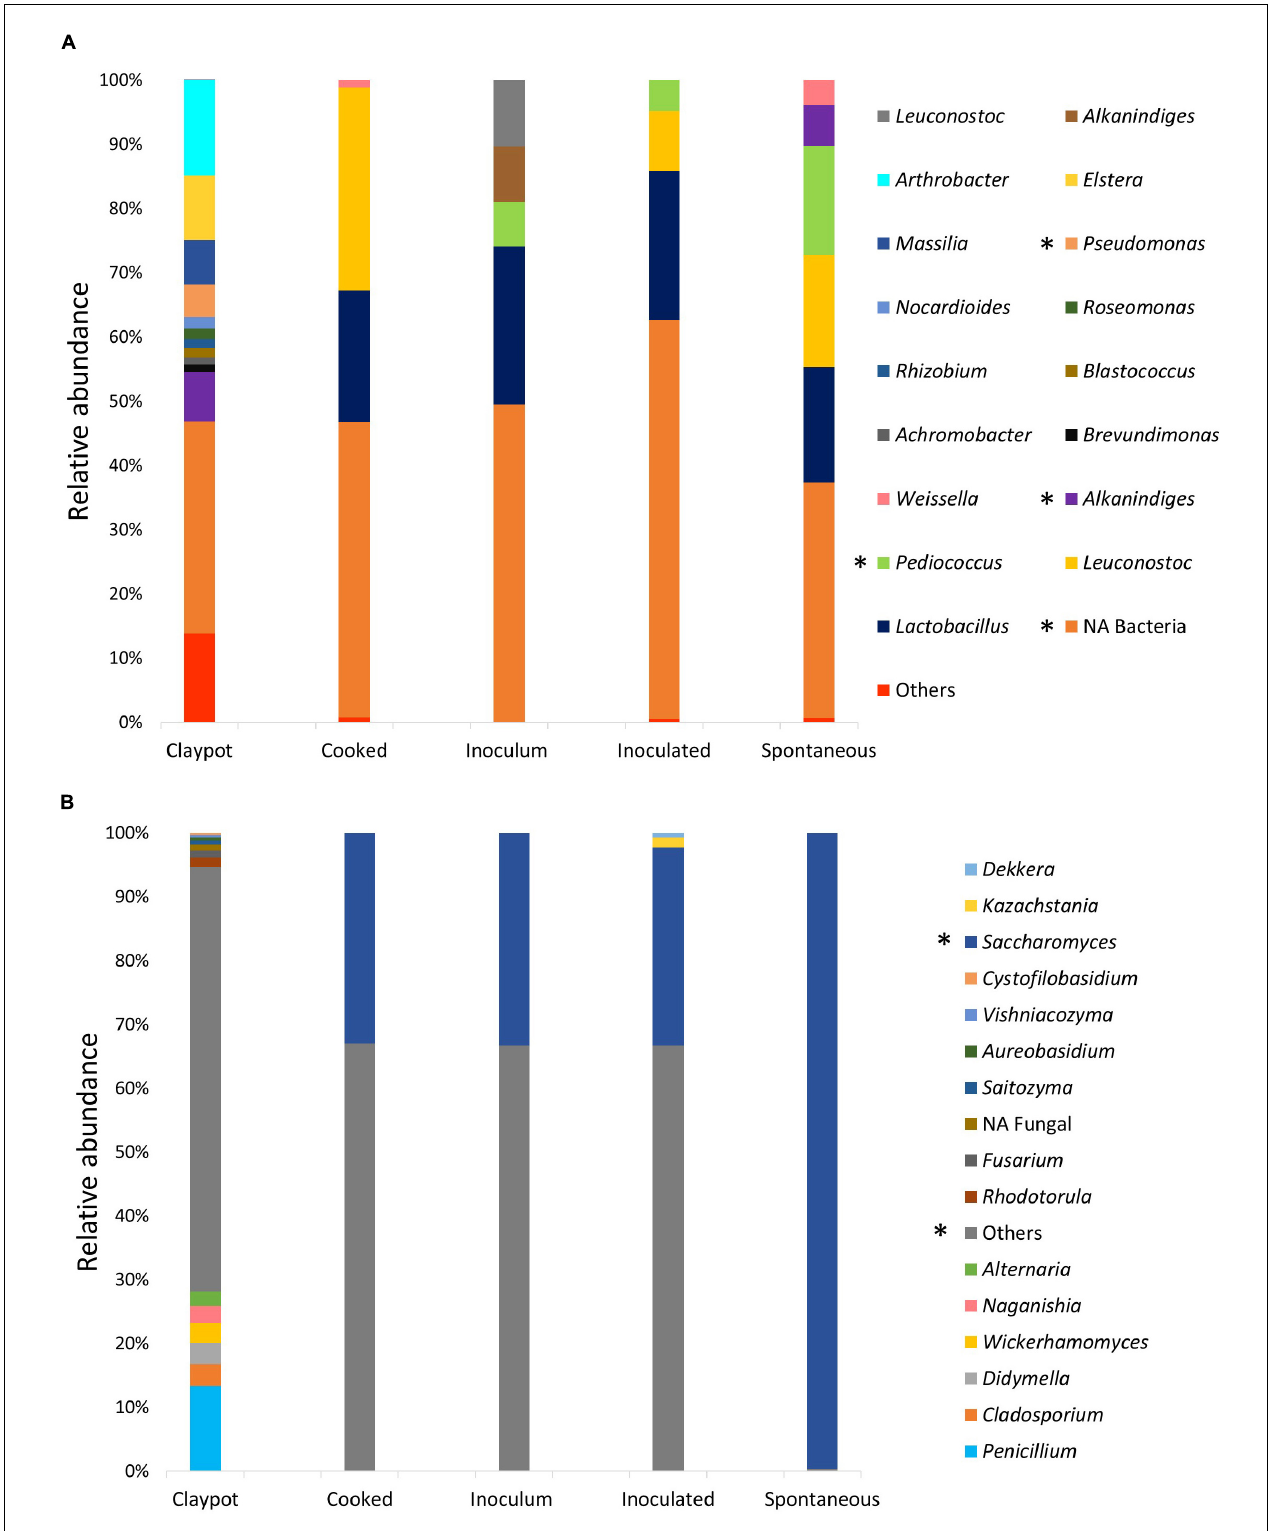
FIGURE 4 | Composition of the (A) Bacterial Genera composition of the community associated with the management practices and colonche production stages and, (B) the fungal Genera composition. Low abundance taxonomic groups (relative abundance < 1%) were reported as others. NA mean not assigned. The asterisk indicates significant differences in taxa relative abundance between management